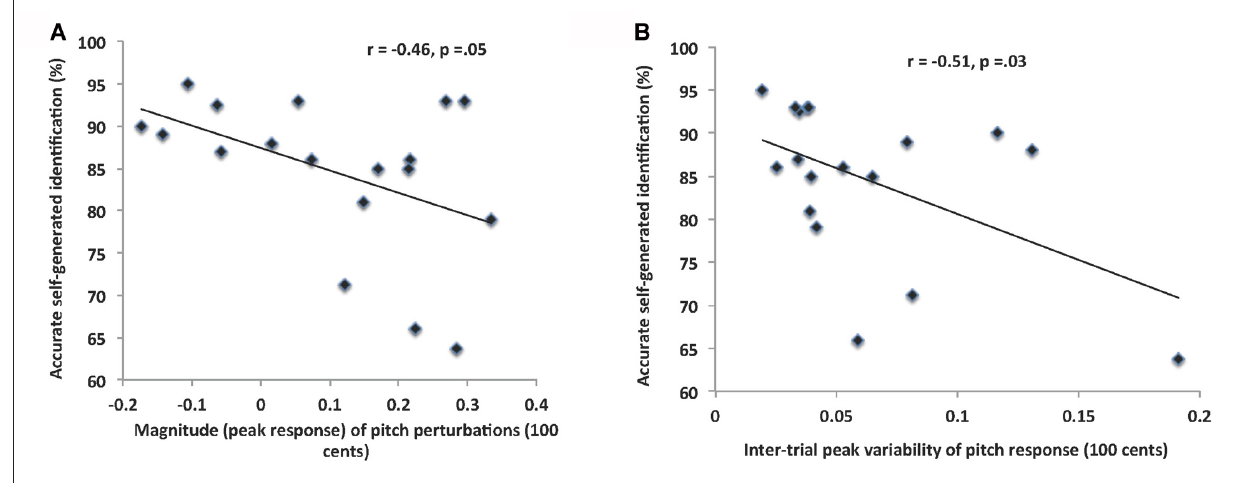
FIGURE 4 | (A) The scatterplot illustrates the significant negative correlation between peak response to 100 cents pitch perturbations and judgments of self-agency on the reality monitoring task. (B) The scatterplot illustrates the significant negative correlation between the inter-trial variability in peak response to 100 cents pitch perturbations and judgments of self-agency on the reality-monitoring